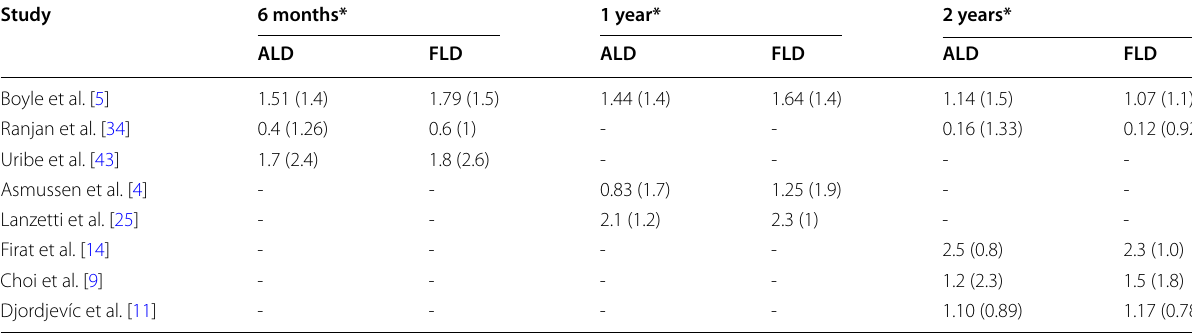
Data are presented as mean ± SD * All results were non-significant with a p -value >